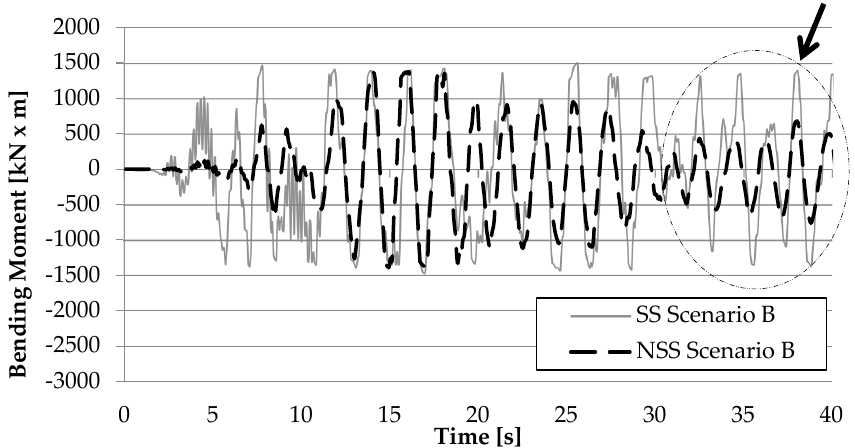
Figure 17. Comparison of moment My at the base of southern pile 14, time history BSC (Laviano)–load scenario B (with traffic load included).